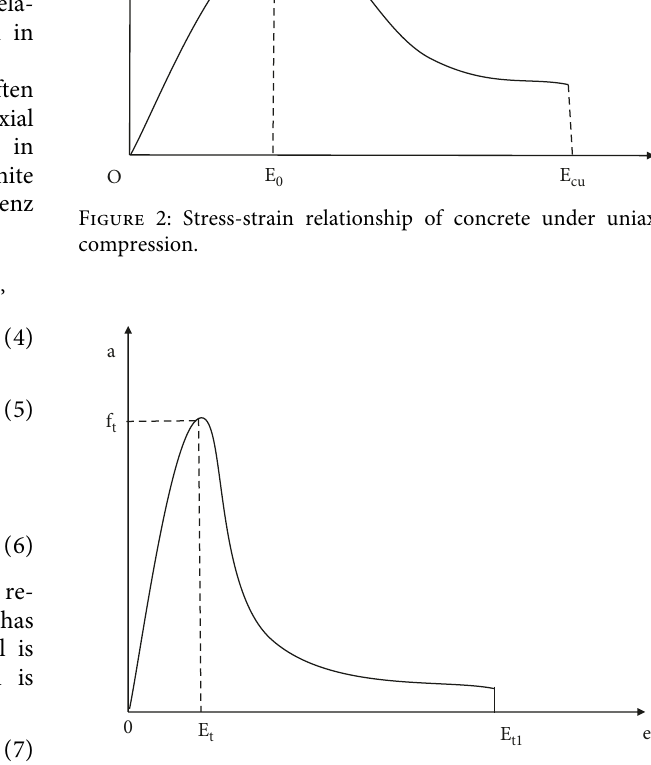
Figure 3: Stress-strain relationship of concrete under uniaxial